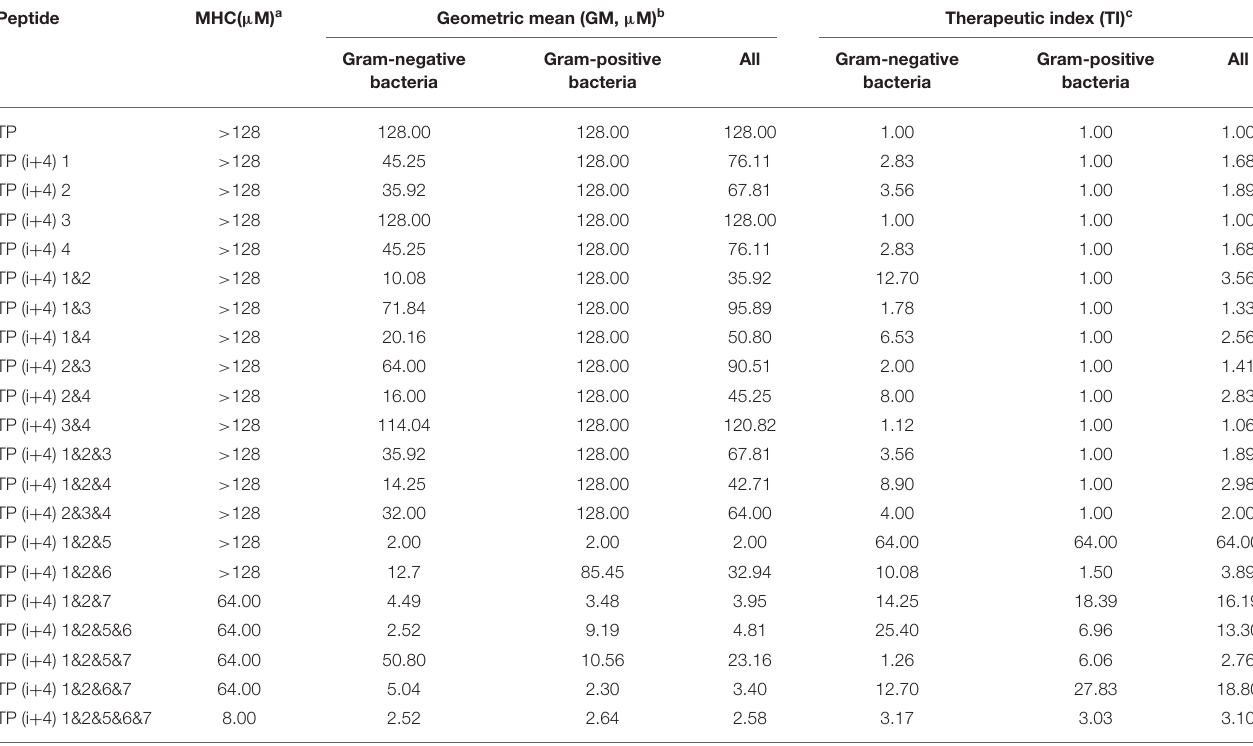
TABLE 3 | The MHC, GM, and TI values of the peptides. Peptide